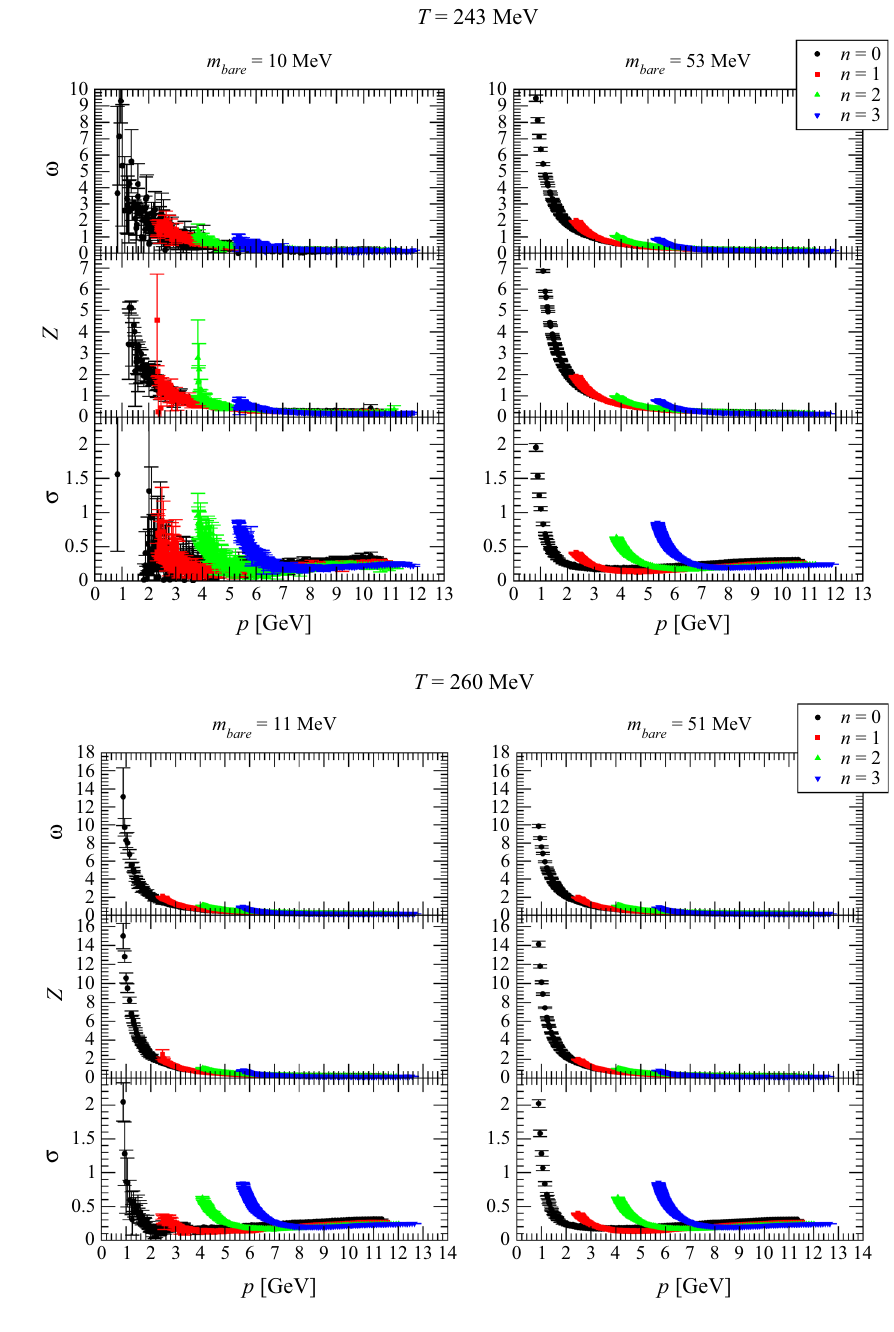
Fig. 1 The bare lattice form factors (10), (11), (12), in lattice units, as a function of (cid:9) + p 2 for the various p = p 2 4 Matsubara frequencies. The m bare = 11 MeV data for the smaller momenta has large fluctuations and some of the data points fall outside the range of the axis values. In the legend of the y axis, when reading ω it refers to definition given in Eq. (10), Z to Eq. (11) and σ to Eq. (12)